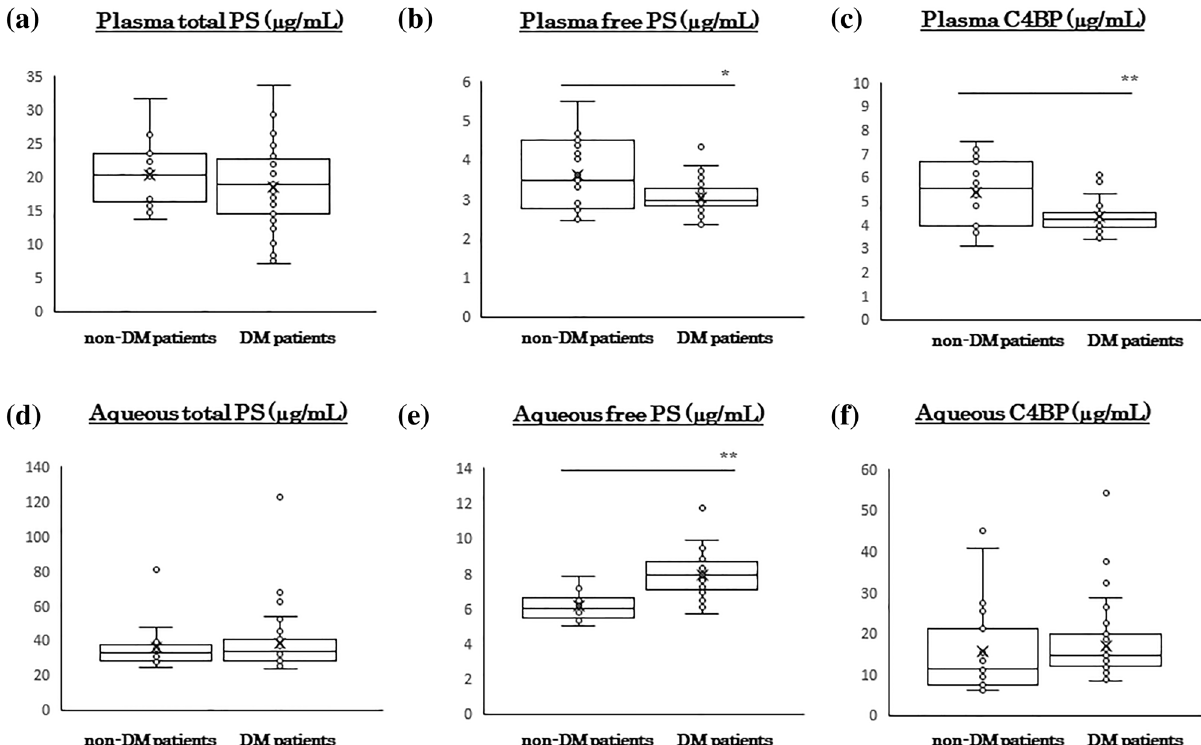
Figure 1. Plasma and aqueous humor concentrations of Protein S and related molecules in patients with or without diabetes mellitus (DM). The plasma concentration of total PS is not significantly different in the DM patients and non-DM patients ( a ). Plasma levels of free PS and C4BP are significantly lower in the DM patients than in the non-DM patients ( b , c ). The total PS and C4BP levels are not significantly different among the different groups ( d , f ). The free PS level in the aqueous humor is significantly higher in the DM patients than in the non-DM patients ( e ). C4BP, C4b-binding protein; DM, diabetes mellitus; PS, protein S. * P < 0.05, ** P < 0.01. Statistical analyses by Mann–Whitney U